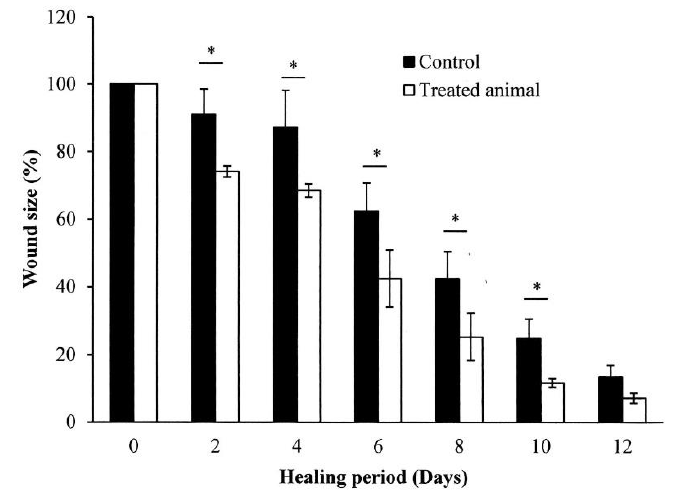
Figure 7. Photomicrographs of the wounds in rats after topical treatment with and without S. mukorossi seed oil on days 0, 2, 4, 6, 8, 10, and 12.